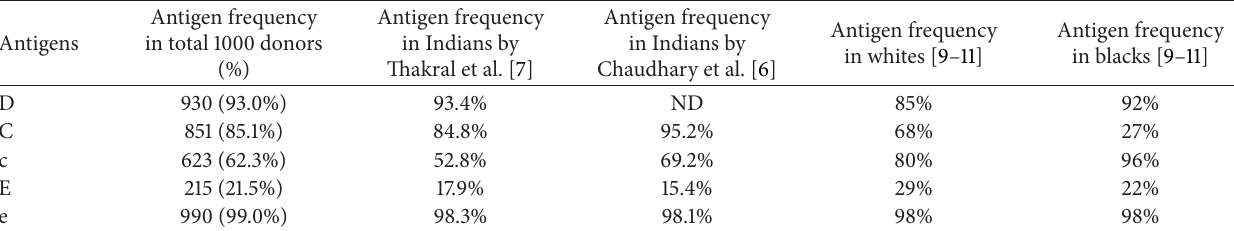
Table 1: Comparison of antigen frequency of Rh subgroup antigens.